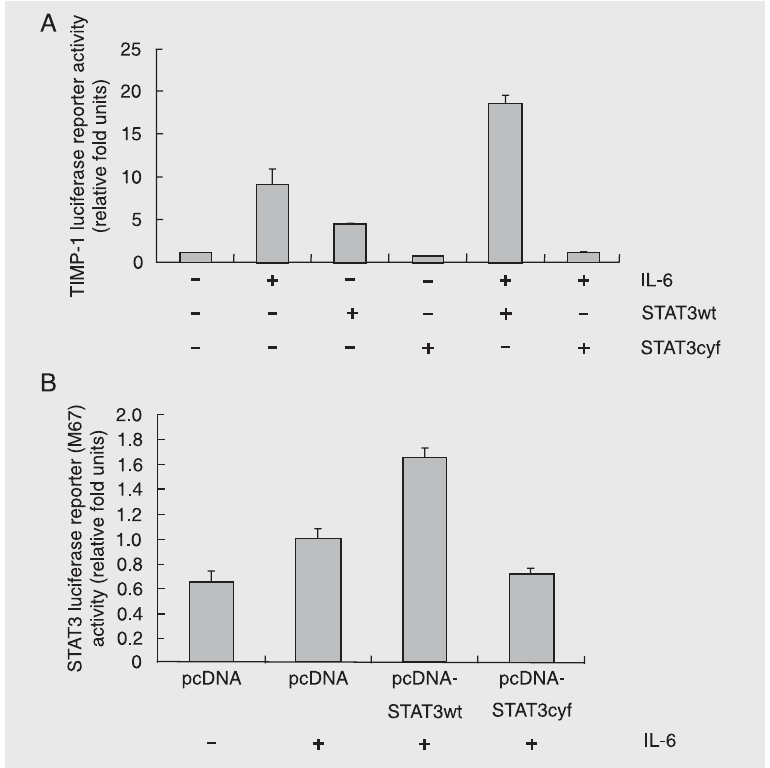
Figure 3. A, The induction of tissue inhibitor of metalloproteinases (TIMP-1) by interleukin-6 (IL-6) was STAT3 dependent, as demonstrated by a TIMP-1 luciferase reporter activity assay. Cells were transfected with TIMP-1 reporter plasmids, co-transfected together with the STAT3wt or STAT3cyf constructs. The cells were then treated or not with IL-6. B, Functional identification of STAT3wt/cyf protein using a STAT3 reporter (M67) activity assay. Cells were transfected with M67 reporter plasmids, co-transfected together with the pcDNA, pcDNA- STAT3wt or pcDNA-STAT3cyf constructs. The cells were then treated or not with IL-6. Each group was co-transfected with the ß-gal reporter plasmid to normalize the transfection